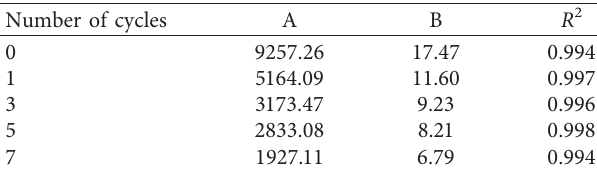
Table 3: Fitting parameters of equation (2) for the data of com- pression tests.